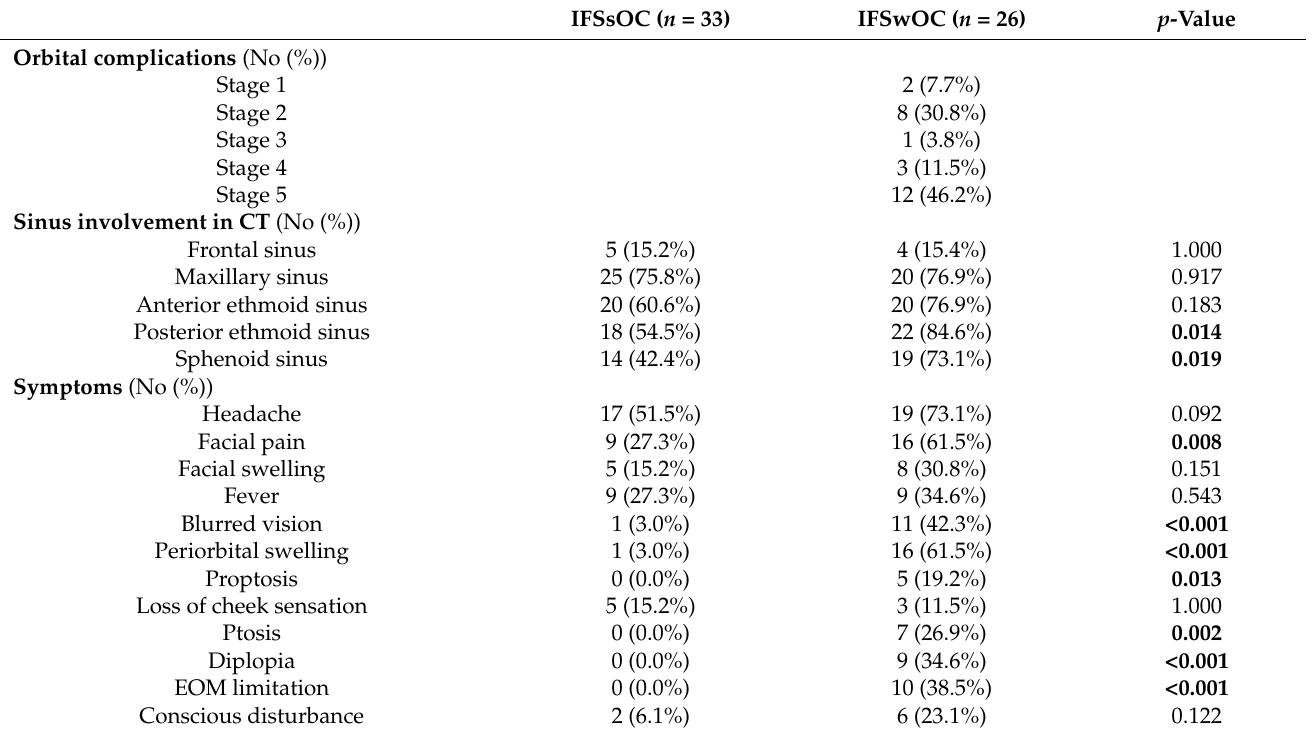
Table 5. Grading of orbital complications, radiological findings, and symptoms between the IFSsOC group and IFSwOC